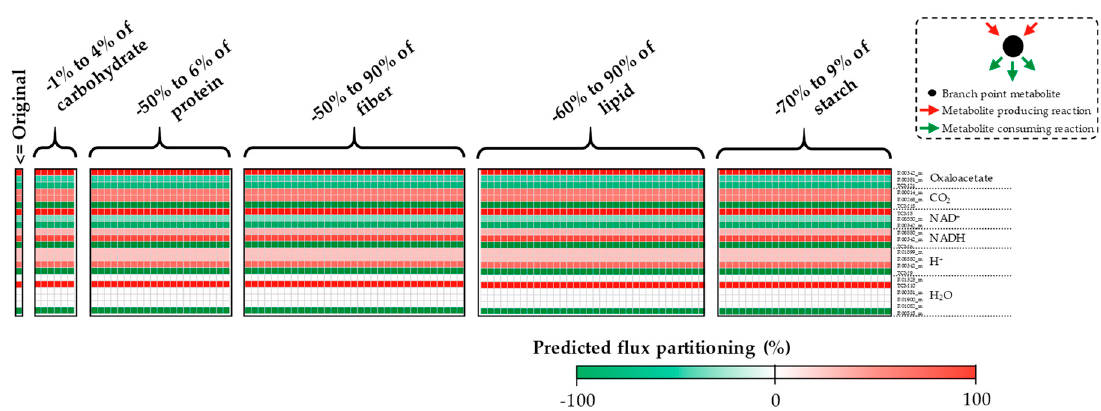
Figure A14. The sensitivity of mitochondrial reaction flux partitioning to variations in biomass content. Details of the metabolic branch points along with the corresponding reactions are provided in the Supplementary Materials (File S2). A difference in grid color between the original (first column) and predicted fluxes is indicative of a dissimilarity in partitioning (breakpoint). The production and consumption fluxes at each metabolic branch point were respectively denoted as positive and negative signs.